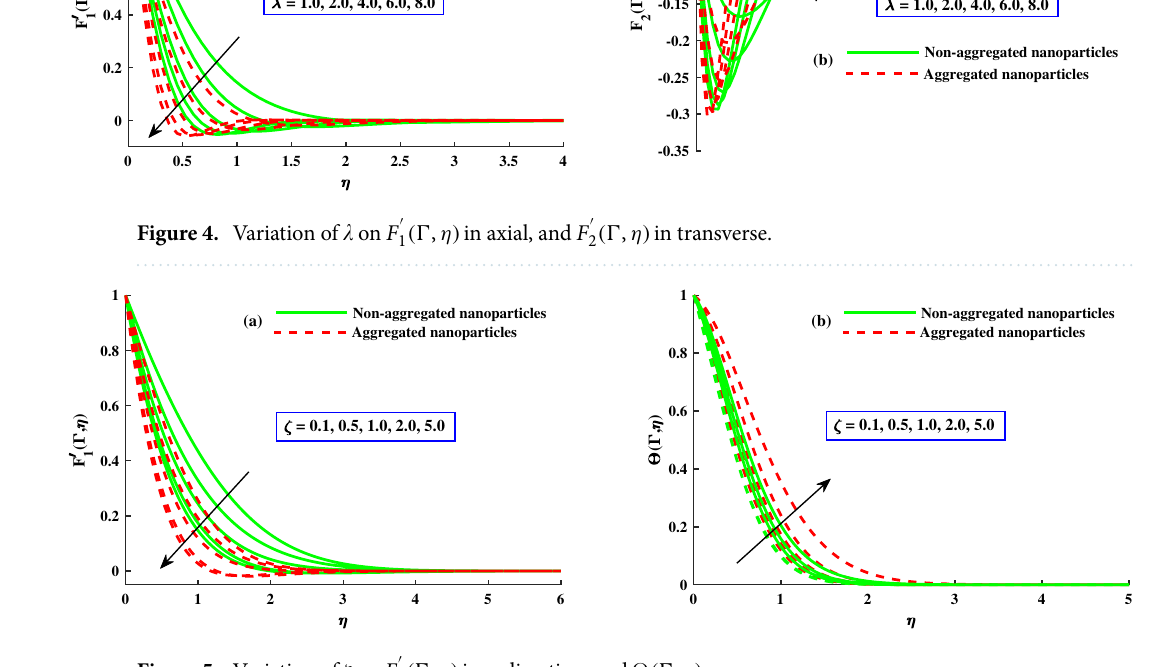
Figure 5. Variation of ζ on F ′ 1 (Ŵ , η) in x-direction, and �(Ŵ , η)